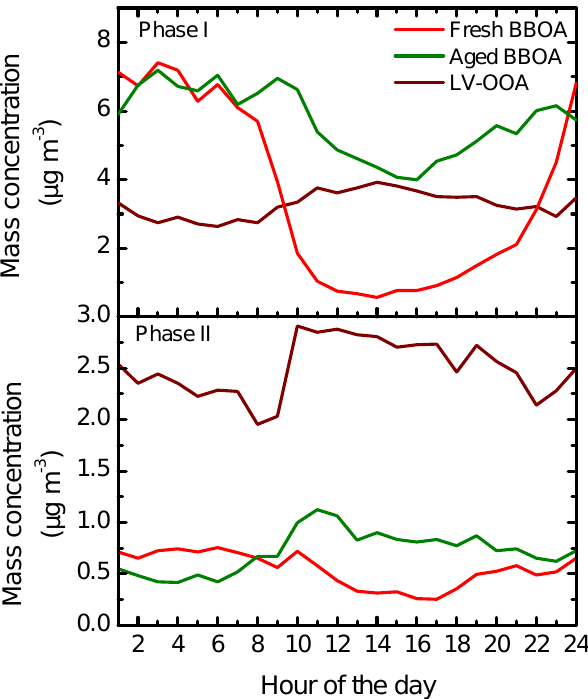
Figure 12. Diurnal variation of the three factors identified through PMF: fresh BBOA, aged BBOA, and LV-OOA. Phase I refers to the period between 13 to 22 September 2012 and Phase II from 22 to 30 September 2012.